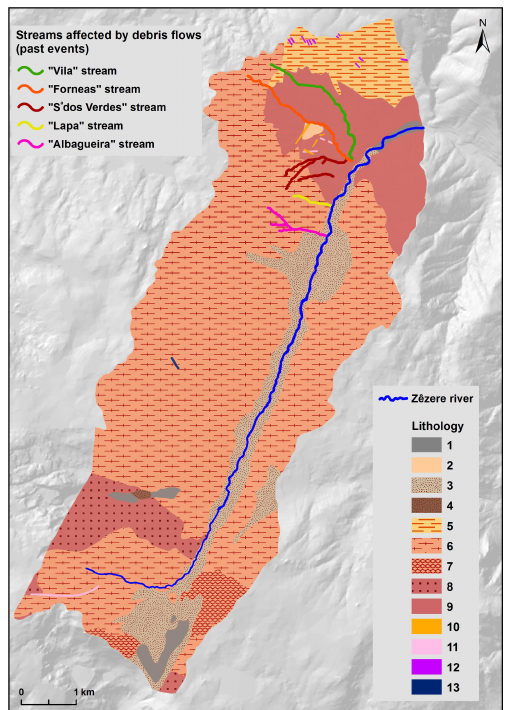
Figure 2. Lithology of the study area and streams affected by historical occurrences of debris flows. Lithology: 1 = alluvium; 2 = slope deposits; 3 = fluvioglacial deposits; 4 = glacial deposits; 5 = contact metamorphic rock (hornfels); 6 = porphyritic medium- to coarse-grained two-mica granite; 7 = porphyritic medium- grained two-mica granite; 8 = non-porphyritic medium- to coarse- grained muscovite granite; 9 = non-porphyritic medium- to fine- grained biotite granite; 10 = quartz dikes; 11 = basic rock dikes; 12 = metamorphosed basic dikes; 13 = aplite-pegmatite dikes.